Question: Which visualization type does this figure use?
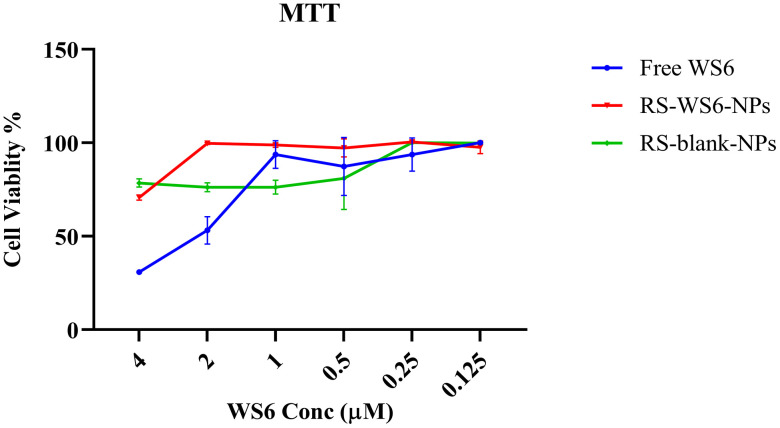
Answer: line